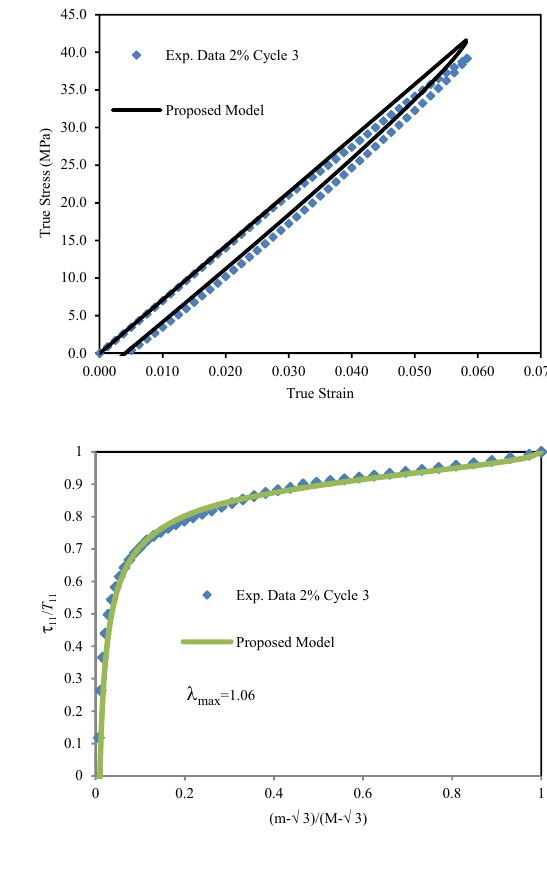
Figure 13. Comparison of theoretical predictions obtained from Equation (25) with experimental data of PC/ABS material reinforced with 2% weight fraction of